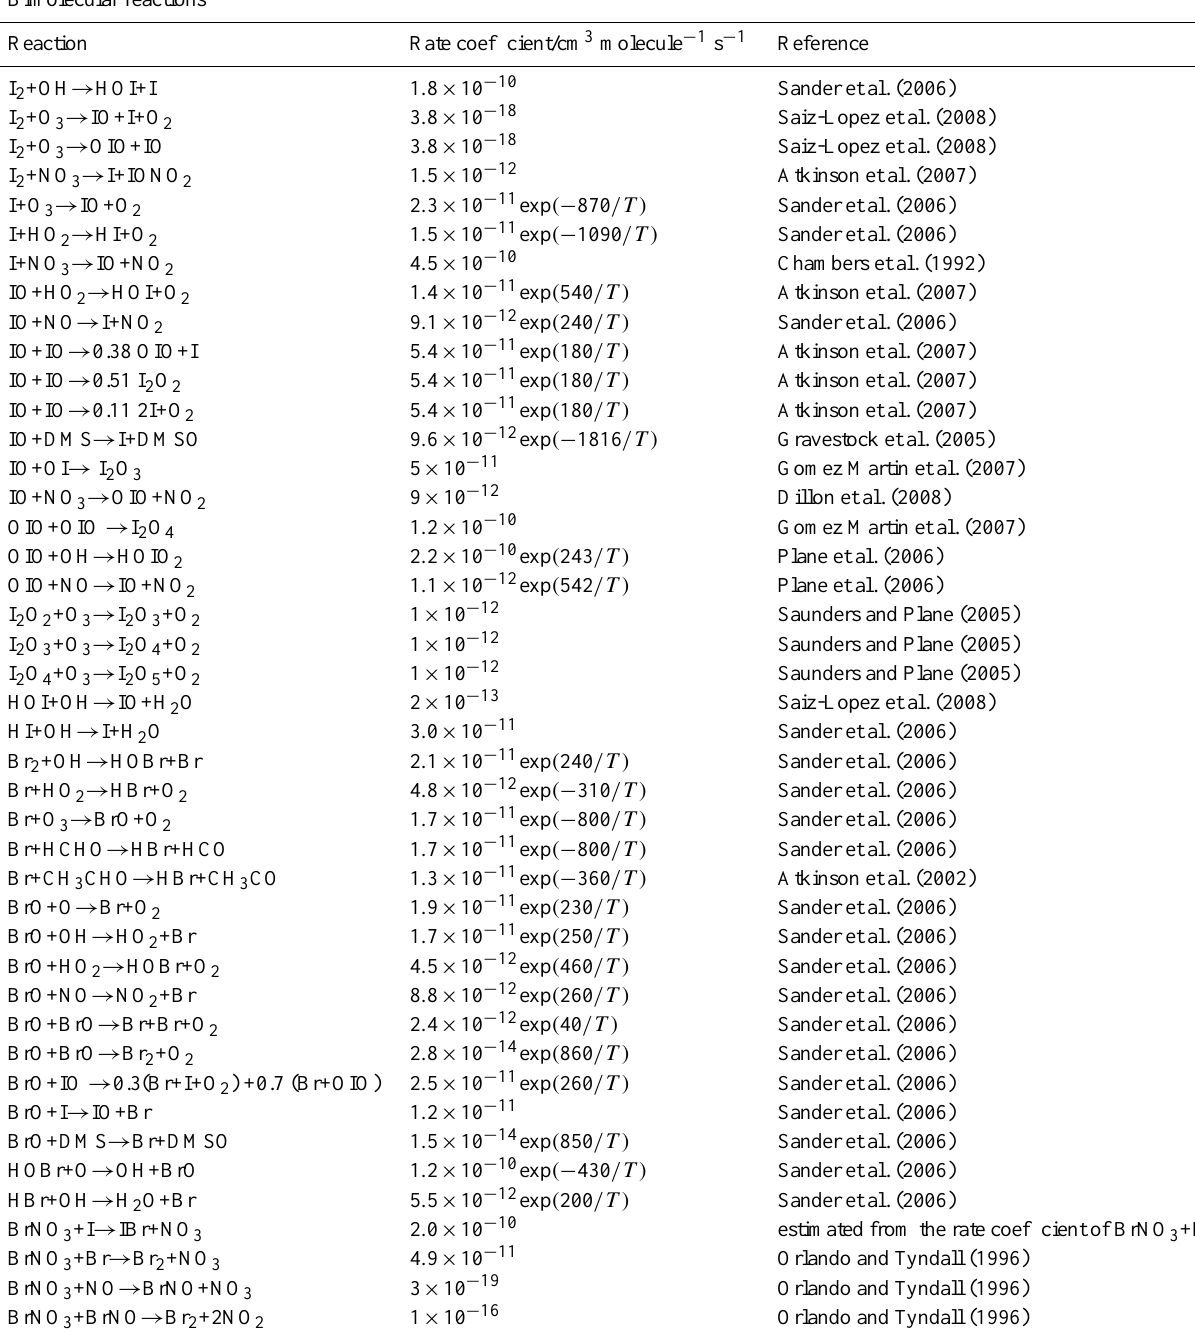
Table A2. Halogen chemistry reaction scheme – bimolecular reactions. DMS=dimethyl sulphide. Bimolecular